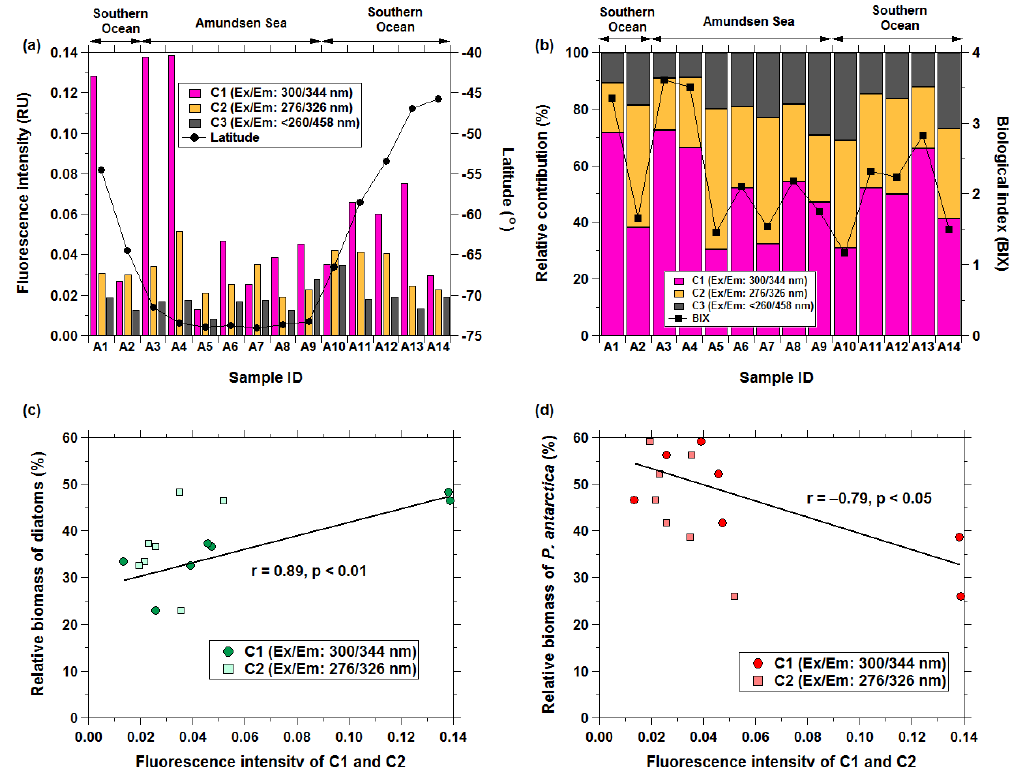
Figure 10. Variations of fluorescence intensities (a) , relative contributions of C1–C3 and biological index (black solid square line) (b) in the fine-mode aerosol particles ( D < 2 . 5µm) collected over the Southern Ocean and the Amundsen Sea. The black solid line with circles in (a) indicates the latitude of the halfway point between each aerosol sampling start point and endpoint. Double arrows in (a) show the sampling locations of aerosol samples. Panels (c) and (d) show the relationship of the fluorescence intensity of C1 to the relative biomass of diatoms and Phaeocystis antarctica ( P. antarctica ) observed in the Amundsen Sea,